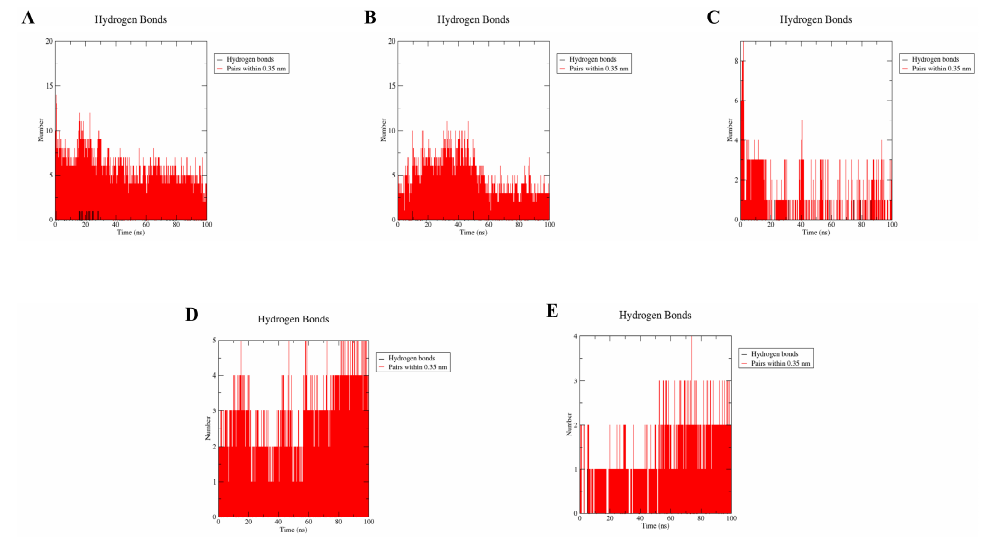
Figure 12. Analysis of hydrogen bond numbers of resveratrol ( A ); bisphenol A ( B ); 17 β -estradiol ( C ); G-1 ( D ); G-15 ( E ).